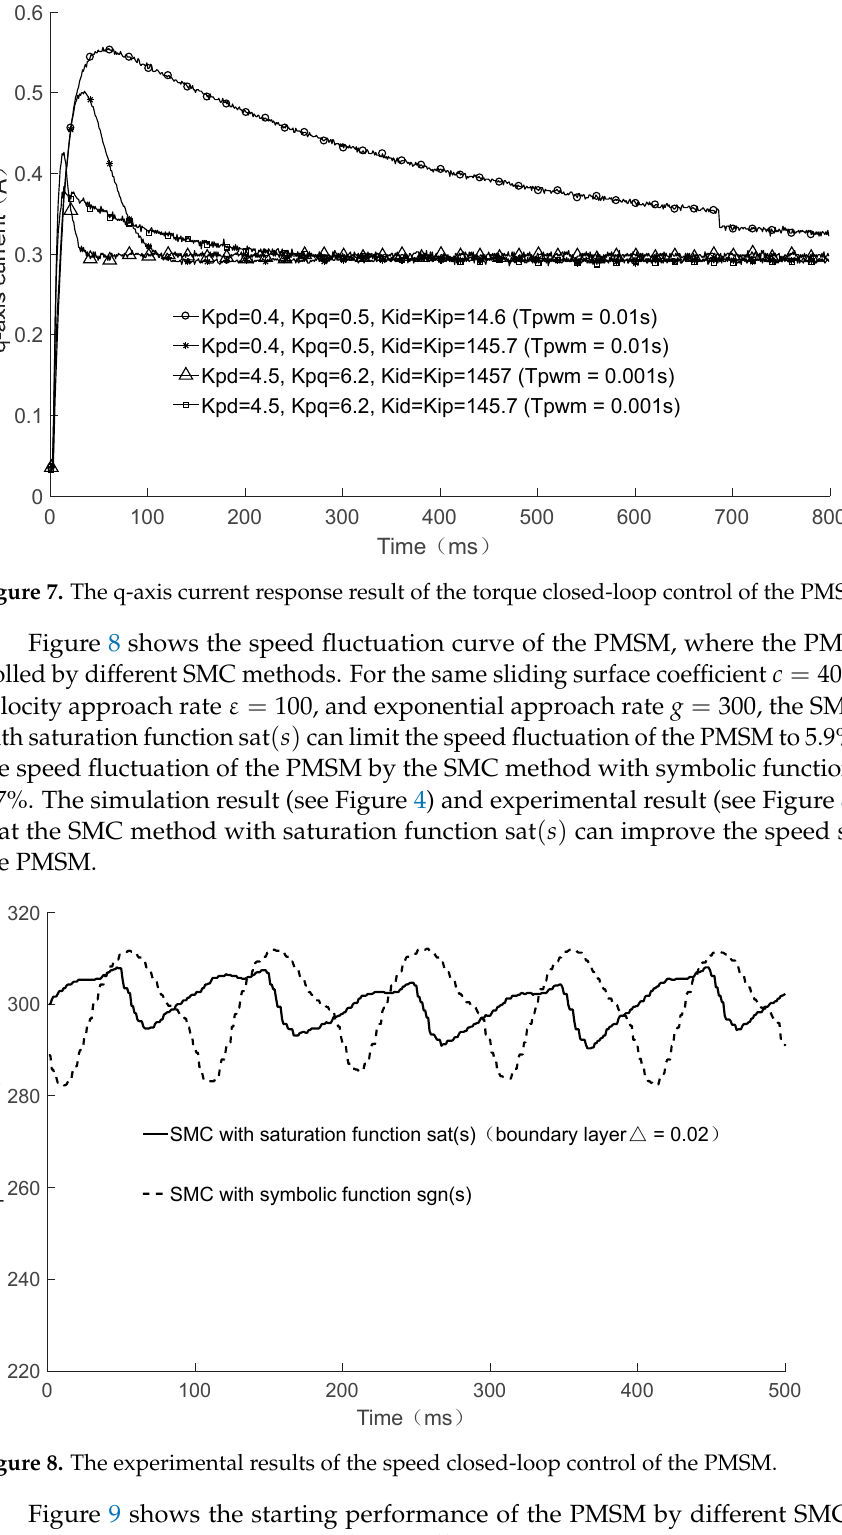
Figure 8. The experimental results of the speed closed-loop control of the PMSM. Under the same sliding mode surface coefficient c = 400, constant velocity approach